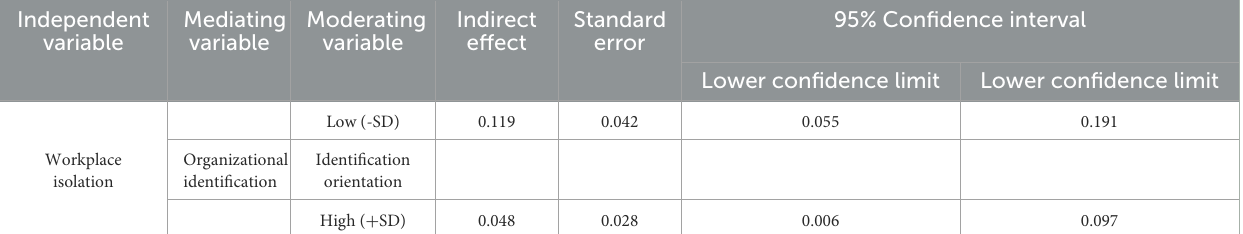
TABLE 9 Moderated mediating effect Bootstrap test